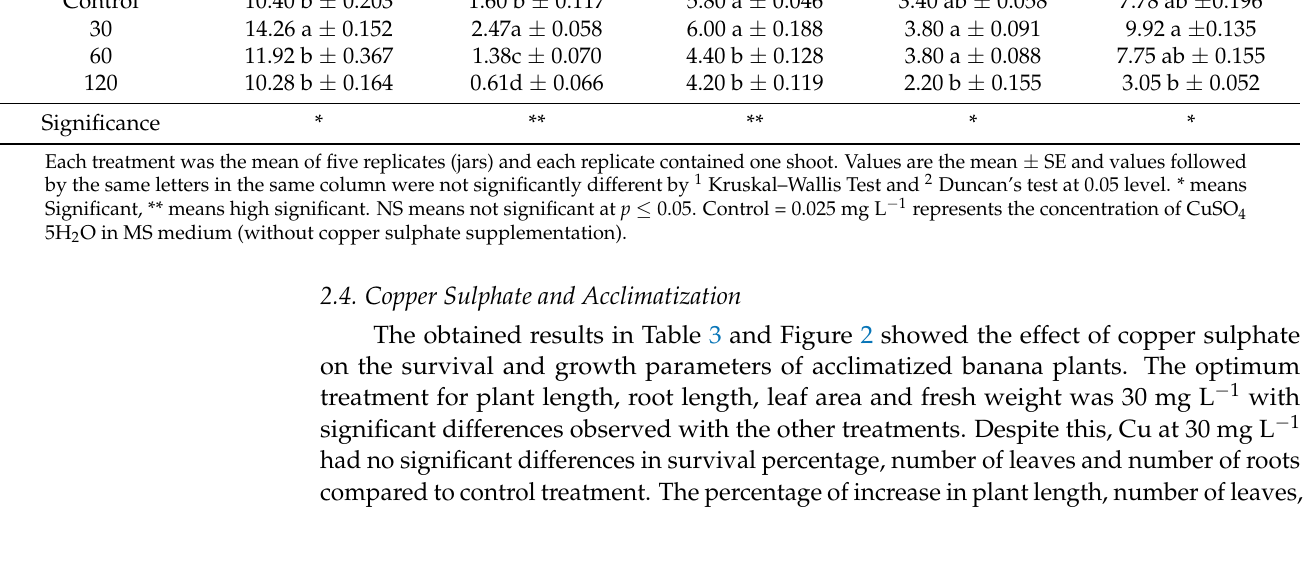
Table 2. Effect of different concentrations of copper sulphate on in vitro rooting of banana plants after 4 weeks of culturing in MS medium fortified with 1 mg L − 1 IBA.